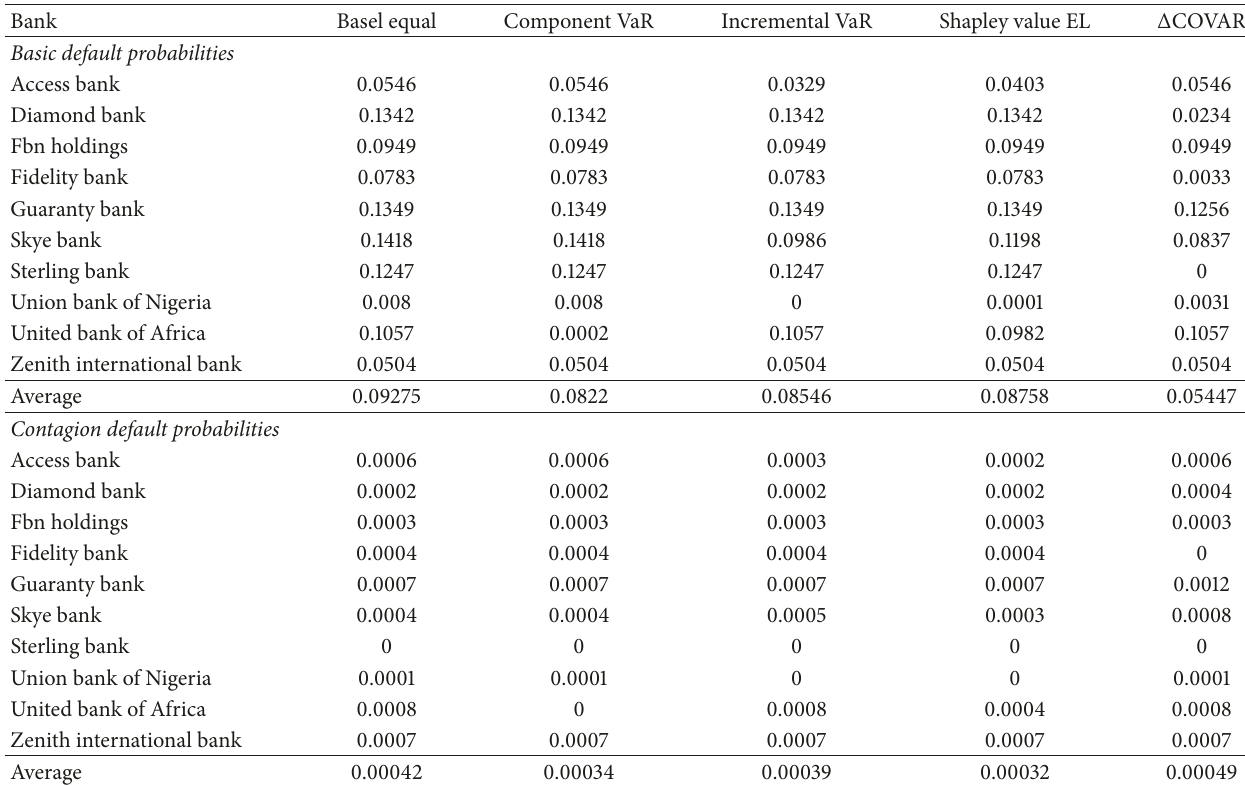
Table 5: Probabilities of Basic and contagious default in